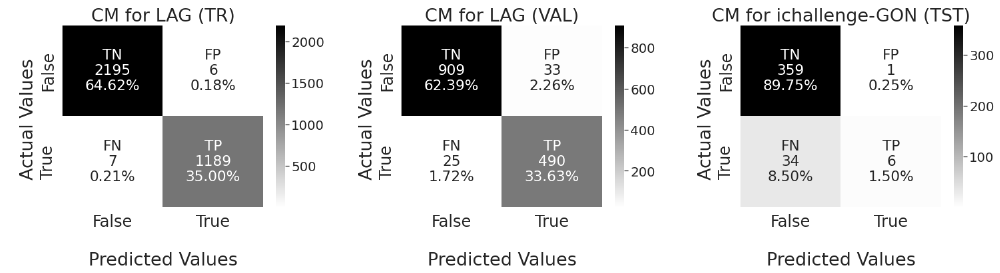
Figure 3. Confusion matrix of ResNet-50 trained parameters for GON.